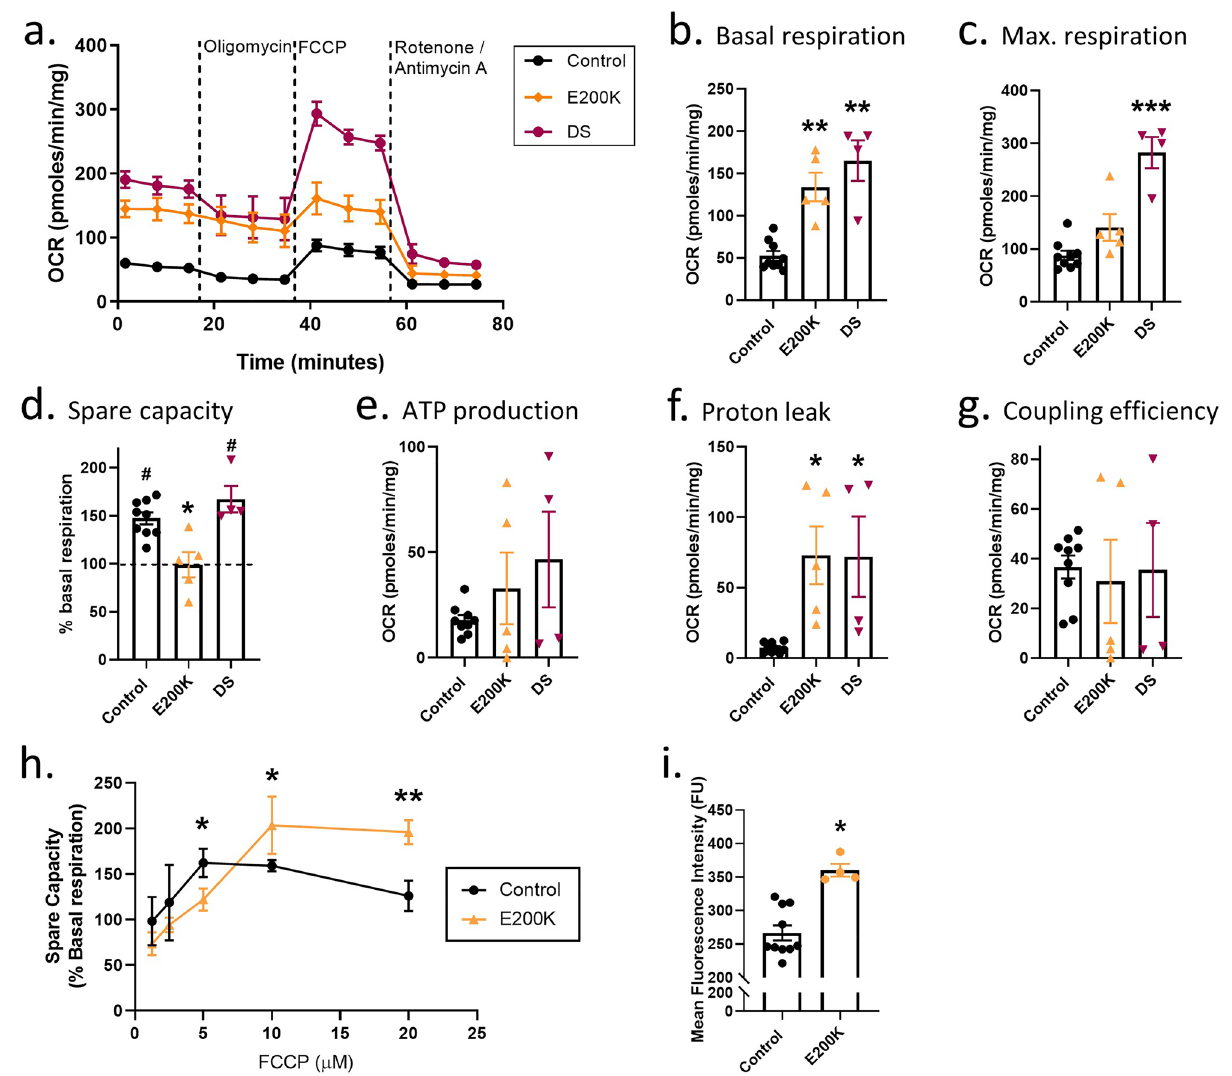
Figure 4. E200K and DS cardiomyocytes demonstrate altered mitochondrial function. ( a ) Example traces showing changes in oxygen consumption rates (OCR) on stimulation or inhibition of the ETC. Traces show the mean and SEM of control (n = 9), E200K (n = 5) and DS (n = 4) cardiomyocytes. Graphs showing ( b ) basal respiration, ( c ) maximum respiration, ( d ) spare capacity, ( e ) ATP production, ( f ) proton leak and ( g ) coupling efficiency calculated from the experimental setup shown in ( a ). ( h ) FCCP titrations of control and E200K cardiomyocytes. Shown are the mean and SEM of six repeats for the control and three repeats for the E200K cardiomyocytes. ( i ) Mitochondrial polarization of control and E200K cardiomyocytes shown as mean fluorescence per cell ( j ). Except for ( a ) and ( h ) as described, graphs show data points of each independent biological repeat ‘ n ’ with mean and SEM, *p < 0.05, **p < 0.01 and ***p < 0.001 change from control, #p < 0.05 change from basal